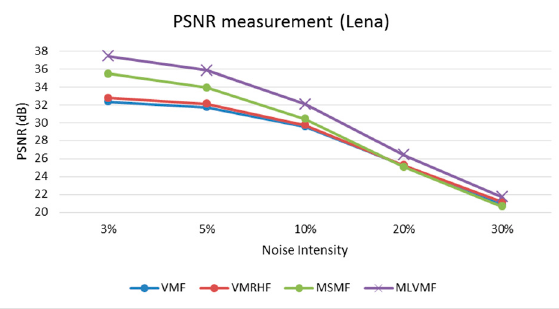
Figure 6. ( a ) Original images. ( b ) Corrupted images with 10% impulsive noise. Filtered images